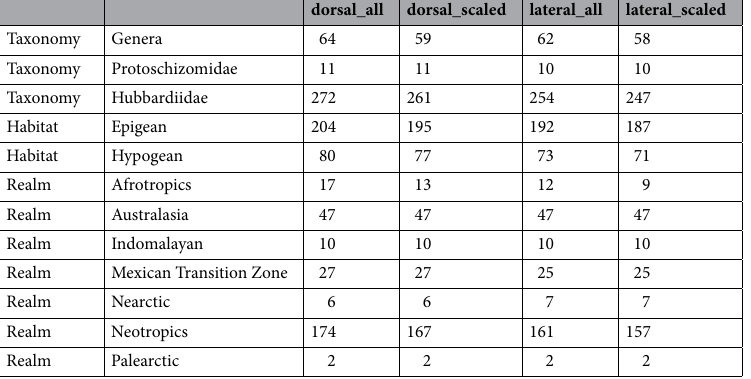
Table 1. Number of schizomid flagellum outlines in each global dataset, categorized by taxonomy, habitat, and biogeographic